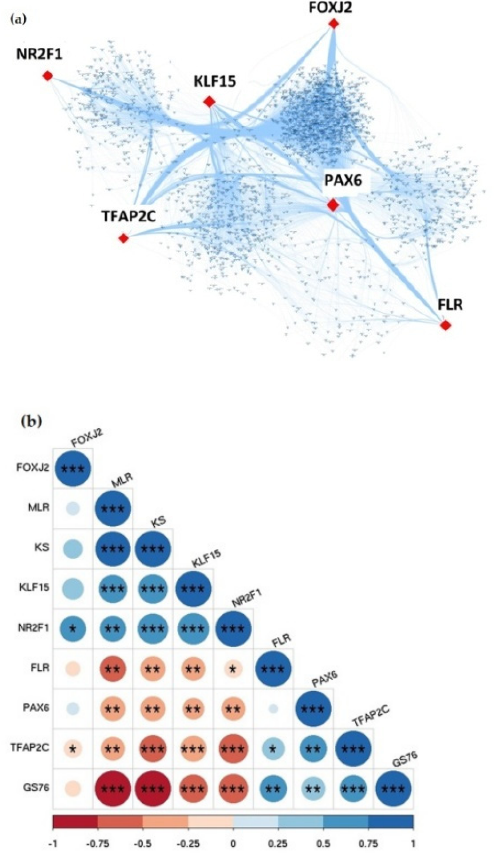
Figure 5. Transcriptional regulatory network analysis of DEGs in GBC. ( a ) Identification of hub TFs in GBC based on degree centrality. The red node represents the top hub TFs and small blue nodes represent target genes. ( b ) Pairwise correlation of EMT score of hub TFs identified through TF-TG interactions. The significance of each hub TFs is represented with a symbol- p -value < 0.001 (***); p -value < 0.01 (**) and p -value < 0.05